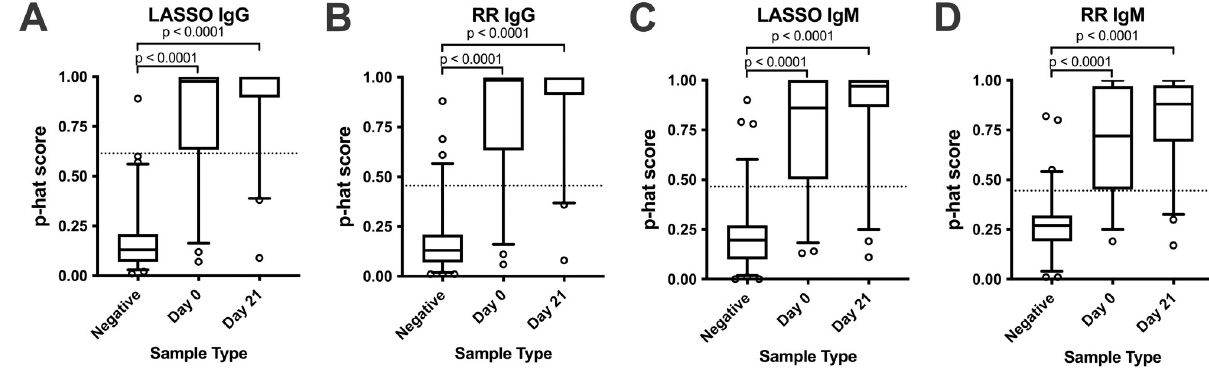
Fig 4. p-hat distribution using the LASSO (A and C) and Ridge Regression (RR, B and D) models. Samples were stratified based on the patient status and collection time. The models were developed using IgG (A and B) and IgM (C and D) reactivity. A ^ p (p-hat) value of 0 is unlikely to be melioidosis and a value of 1 is likely to be melioidosis. A cutoff to call sensitivity and specificity is shown by the dotted line and corresponds to Table 4. ^ p value significance was determined by a Kruskal-Wallis test followed by a Dunns pairwise comparison. The Day 0 vs Day 21 was not significant for all antibody isotype